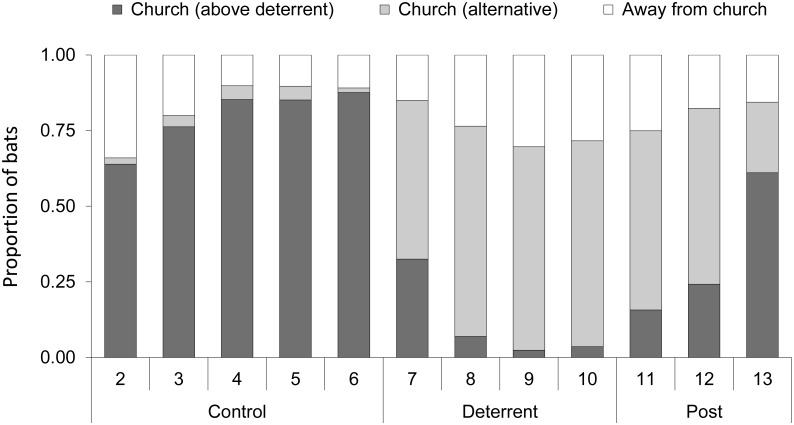
Response of Myotis nattereri to short, four-day applications of the Deaton (ultrasound) device.The figure shows the mean (n = 6 sites) proportion of radio-tagged bats (n = 87) roosting each day in the original roost above the deterrent, at an alternative roost within the church, or at an alternative roost outside the church during control (deterrent off), deterrent (deterrent on) and post-deterrent (deterrent off) periods. The bats were radio-tagged on day 1.